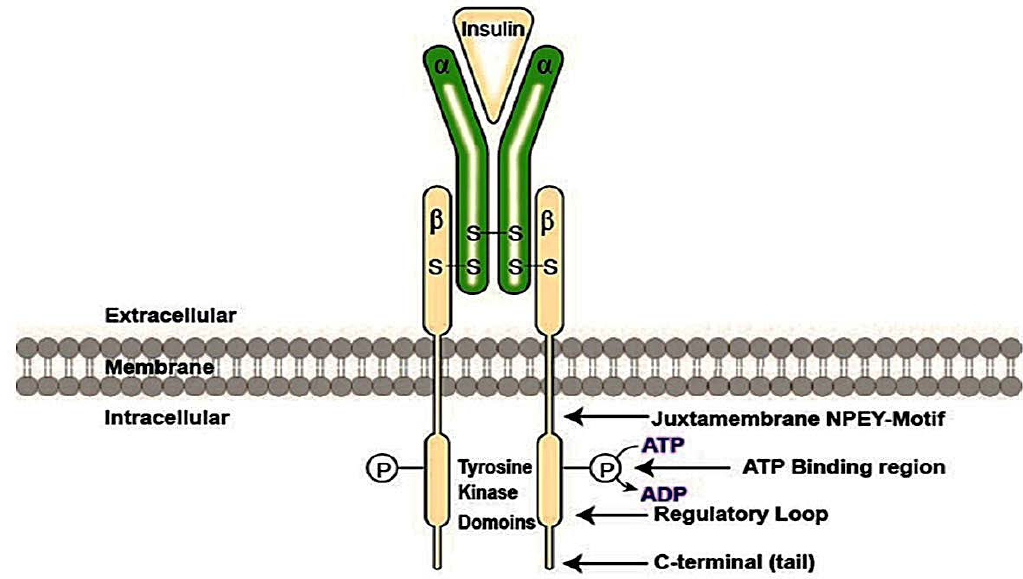
Figure 3. Insulin activates insulin receptor. Subjection of insulin to its receptor brings in the action of insulin and activates insulin receptor which is a type of tyrosine kinase and is comprised of two extracellular α subunits and two cytoplasmic β subunits. Attachment of α subunits to the insulin hormone induces the phosphorylation of β subunits and transferring signals in the entire membrane and activates the intracellular tyrosine kinase domain of the β subunit. Insulin binding activates the tyrosine kinase which leads to autophosphorylation of tyrosine residues in several regions of the intracellular β -subunit, including juxtamembrane region, regulatory loop and C-terminal. The activated IR then phosphorylates phosphotyrosine binding domains on intracellular substrates. Abbreviations: ATP-Adenosine triphosphate, ADP- Adenosine diphosphate, IR- Insulin Receptor, NPEY; Asn-Pro-Glu-Tyr-Motif.